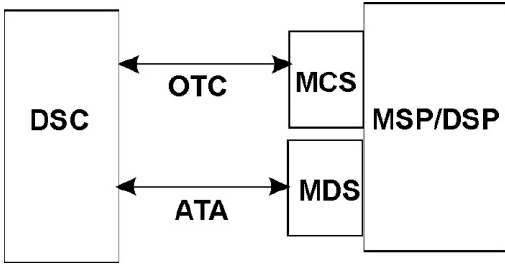
Figure 6. One Time Access Any Time Access (OTC-ATA) Model.